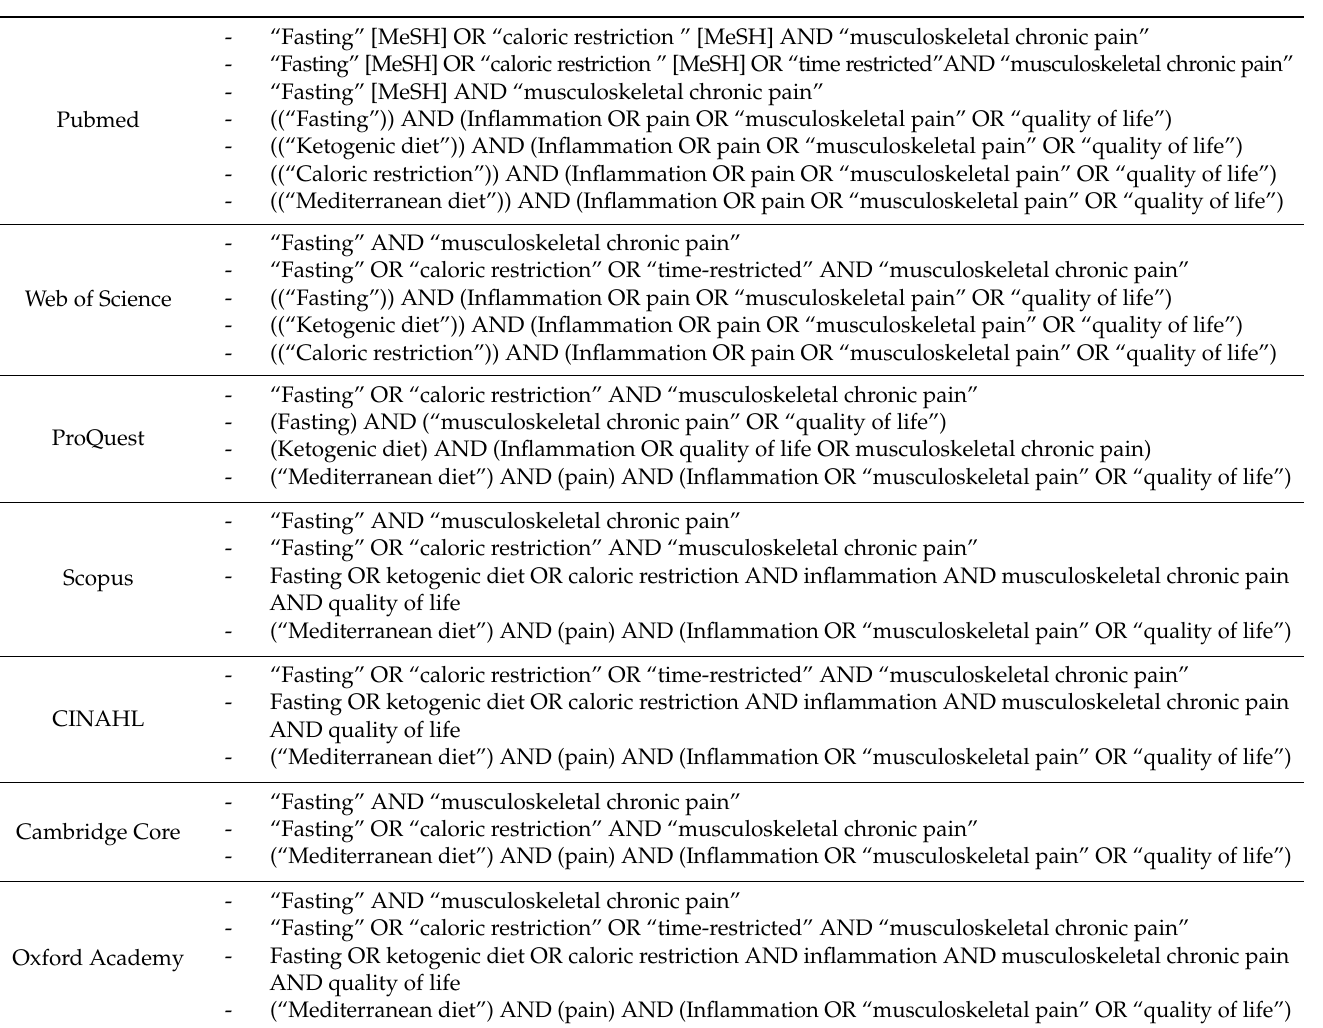
Table 1. Search strategy in the different databases